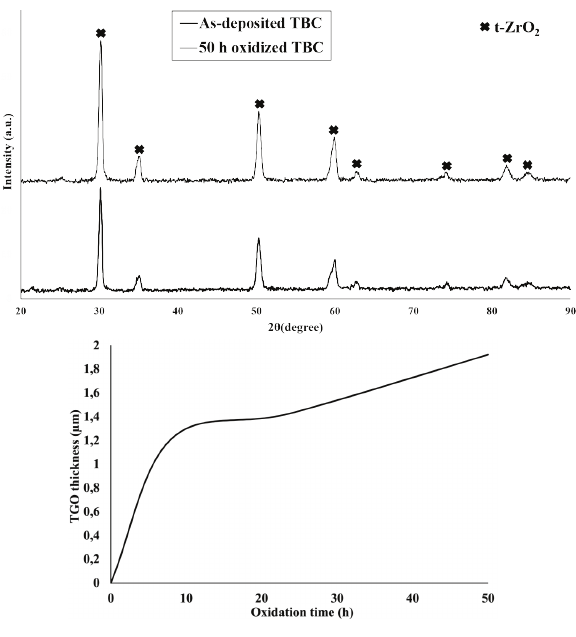
Figure 5: XRD analysis of as-sprayed and 50 h oxidized TBC and, TGO growth behavior with respect to time. Figure 5 shows XRD and TGO growth behavior of TBCs. According to XRD results, phase transformation on the top coat did not occur at the end of the oxidation and the top coat only consisted of tetragonal ZrO 2 (t-ZrO 2 ). Semi-tetragonal ZrO 2 phase is durable at temperatures up to 1173°C , therefore, phase transformation has not occurred [23]. With increased time, TGO layer thickness increased and, with the highest increase observed in initial oxidation stage. Interestingly, TGO thickness exhibits similar growth but lower growth rate compared to CoNiCrAlY TBCs in literature [22,24 ] for isothermal oxidation tests at 1000°C. However, internal oxidation rate can be higher in NiCr TBCs. Thus, results can change at higher dwell times.